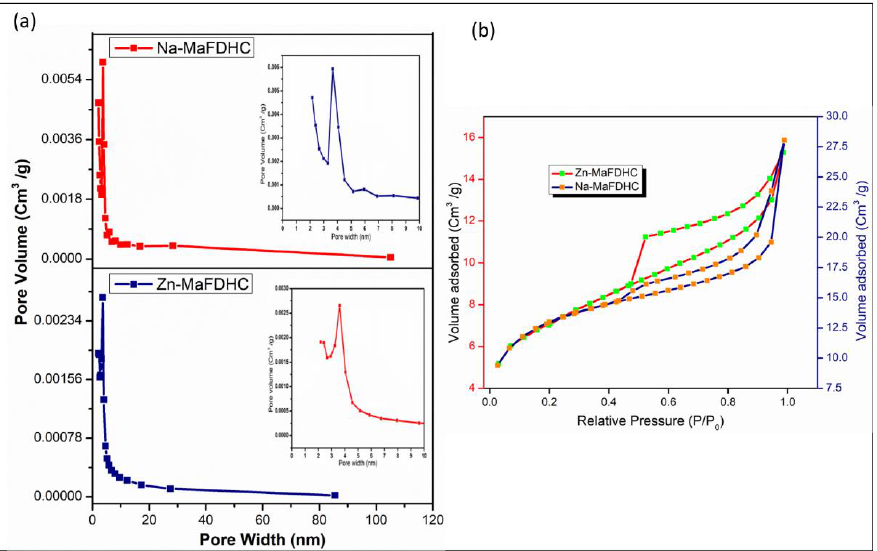
Figure 4. ( a ) Pore size distribution and ( b ) N 2 adsorption and desorption isotherms of Na − MaFDHC and Zn − MaFDHC